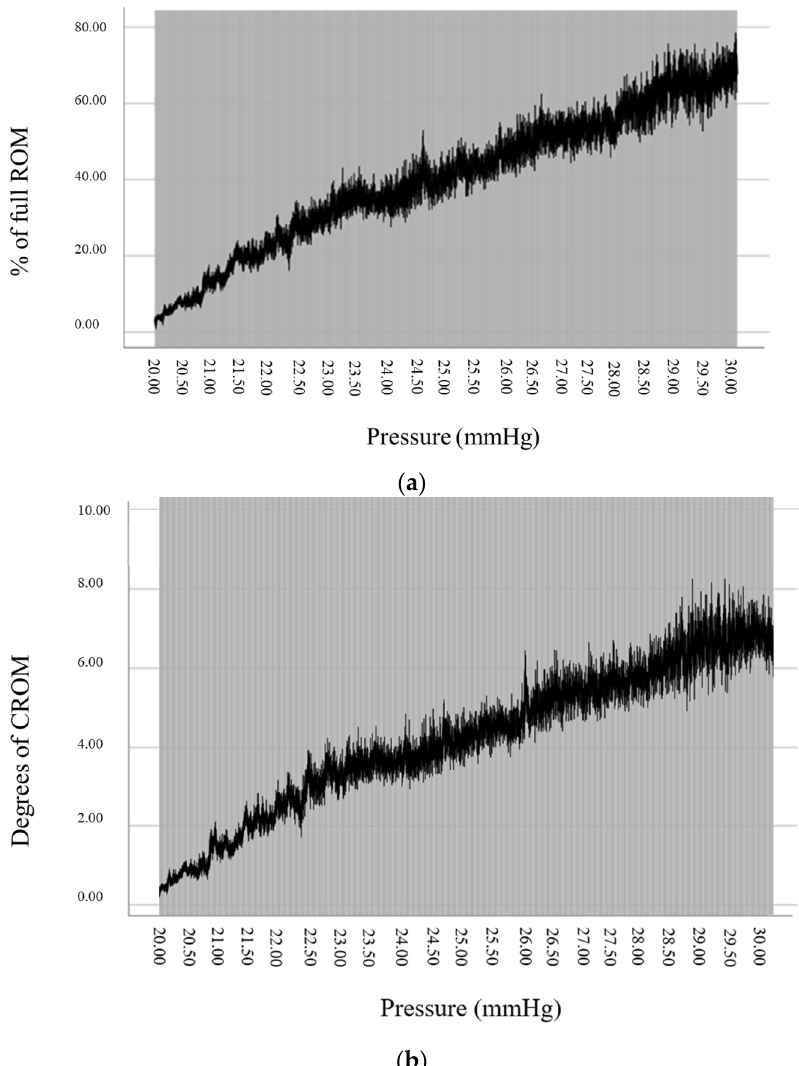
Figure 1. ( a ) Relationship between % of full CCROM and pressure; ( b ) relationship between degrees of CCROM and pressure. Data are represented as mean ± 2 * SE. CCROM: craniocervical flexion range of